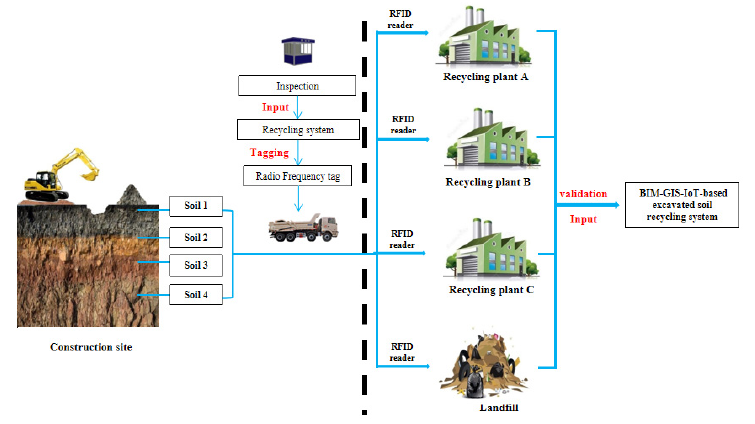
Figure 4. The application of IoT technology in the excavated soil recycling system.